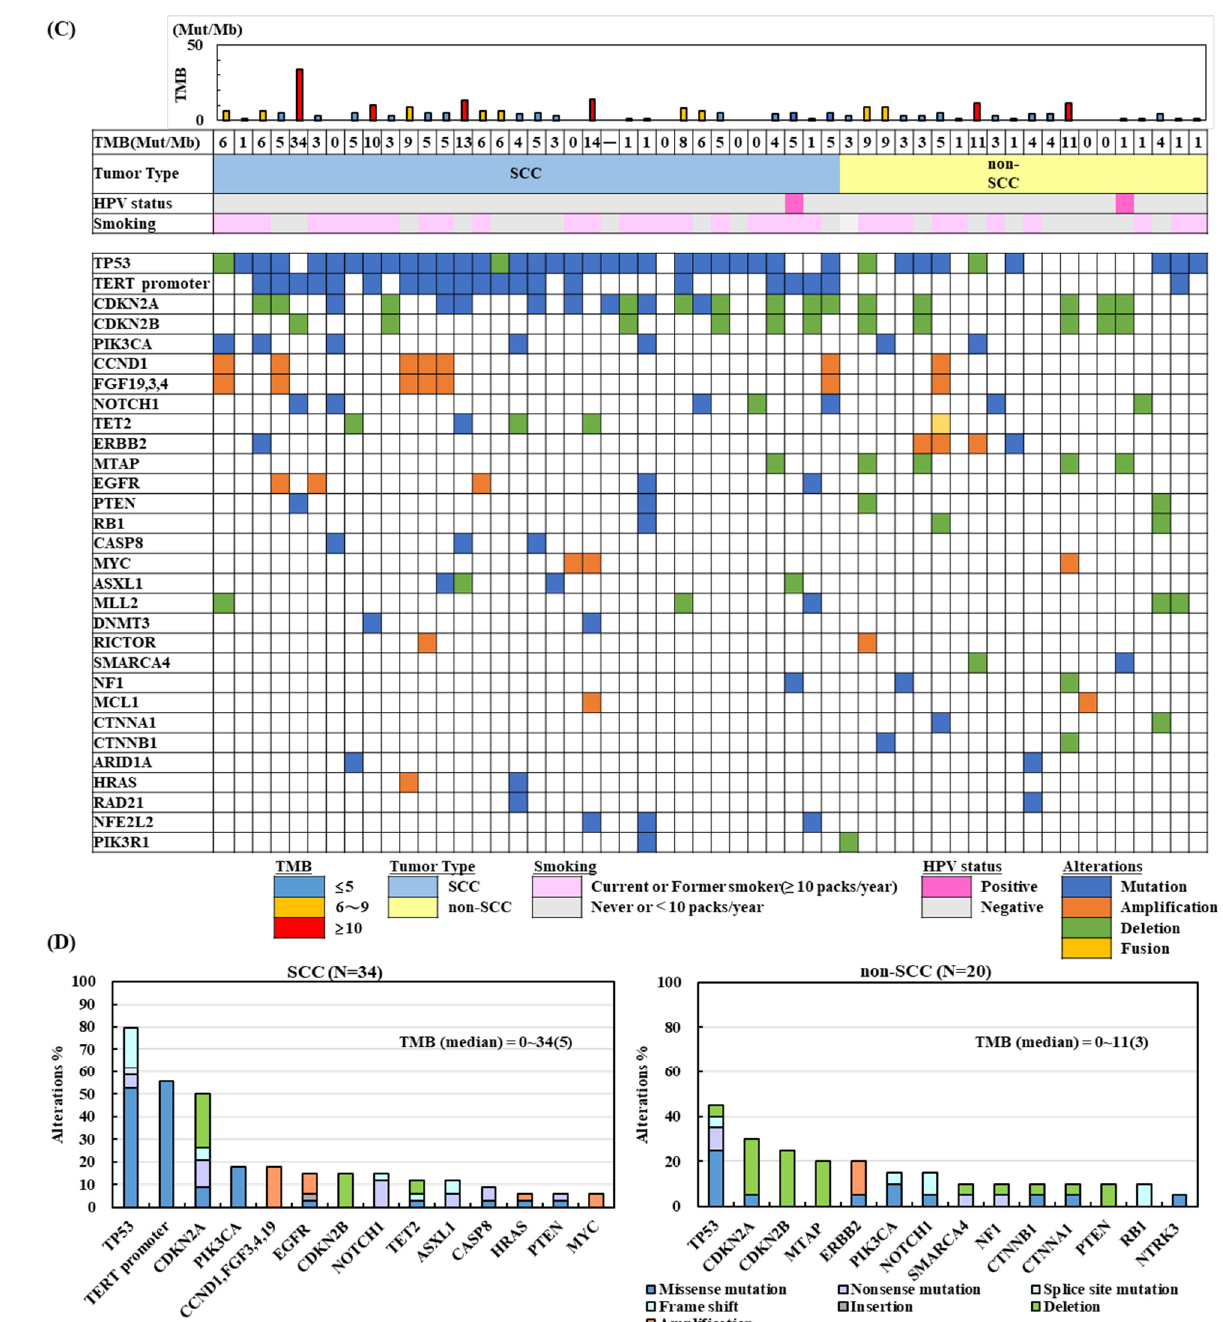
Figure 2. Patient population and sequencing results at our institution. ( A ) Total population in R/M HNC with F1CDx or F1LCDx testing performed at our institution. All SCC patients received ICI therapy; one patient, who received both ICI and chemotherapy, was excluded to evaluate treatment efficacy. ( B ) Percentage of patients with access to treatment for comprehensive genomic profiles by histology. ( C ) The top 30 most frequently detected genetic mutations in all R/M HNC patients. TMB is indicated at the top of the graph as high (red, ≥ 10 Mut/Mb), intermediate (yellow, 6–9 Mut/Mb), and low (blue, ≤ 5 Mut/Mb). The color coding on the graph indicates histological type, smoking his- tory, and type of mutation. ( D ) Frequent genes and variant types by histological type. Color coding indicates mutation type.